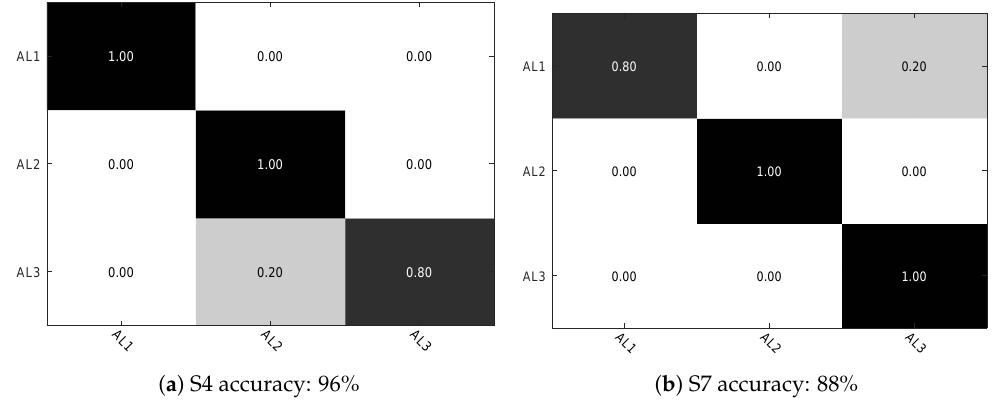
Figure 10. Confusion matrix of predicted activity levels of subject S4 and